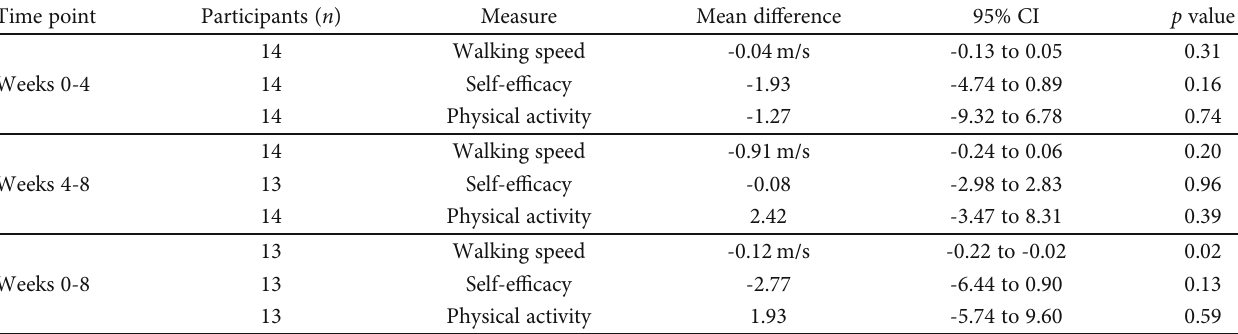
Table 2: Change in outcome measures comparing baseline to week 4 and week